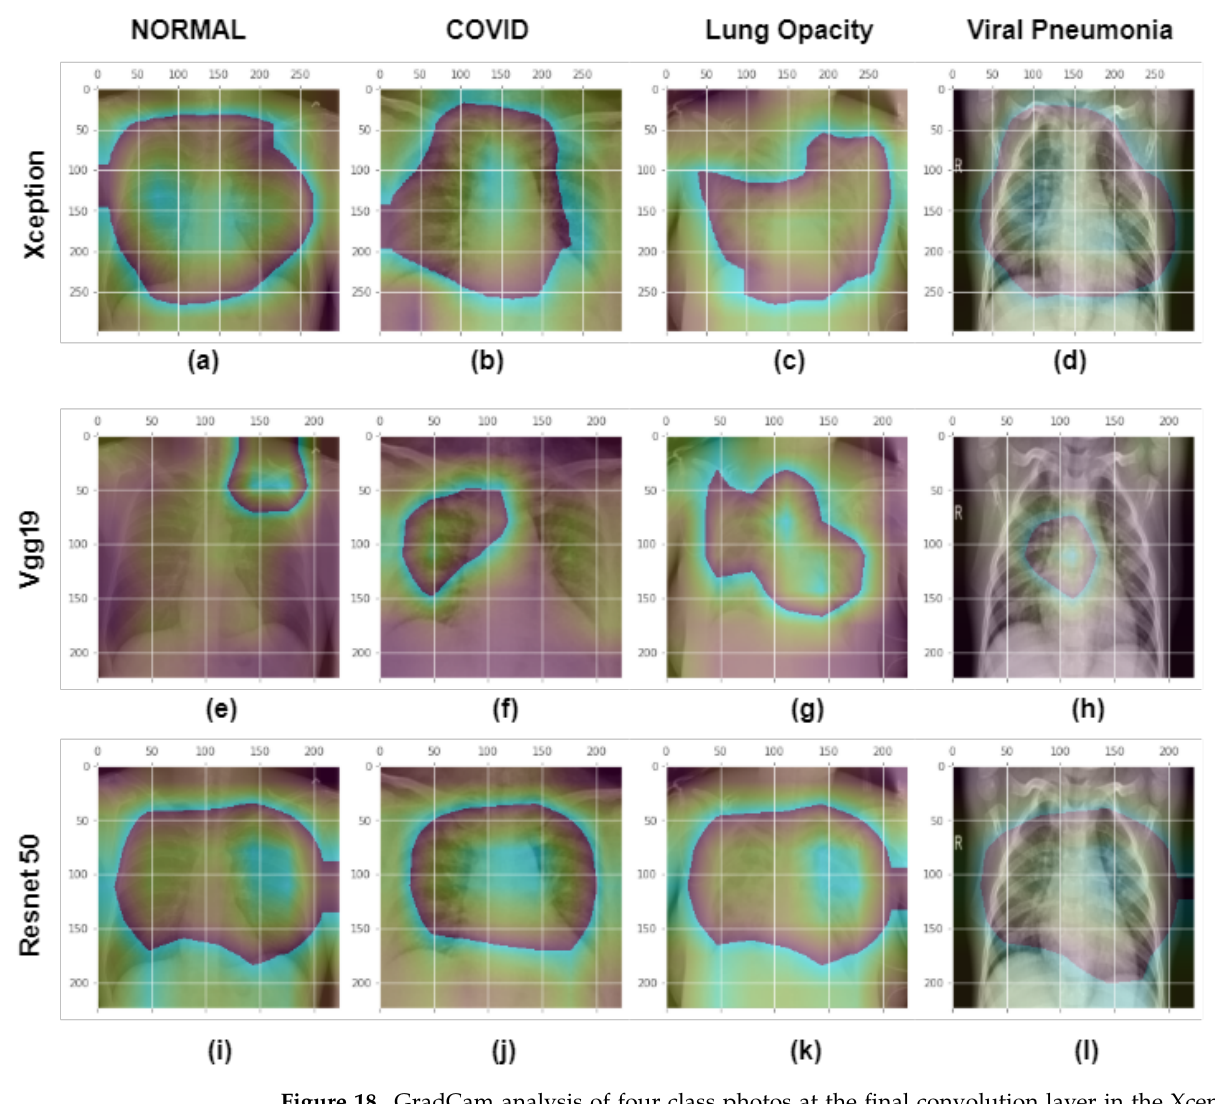
Figure 18. GradCam analysis of four class photos at the final convolution layer in the Xception, VGG19, and Resnet50 models. First row or images ( a – d ): shows superimposed images of different classes in the last layer of the Xception model. Images ( e – h ) or Second row: shows superimposed images of different classes in the last layer of the VGG19 model. Images ( i – l ) or Third row: shows superimposed images of different classes in the last layer of the Resnet model. The first, second, third, and fourth columns display superimposed images of normal. COVID, Lung opacity and non-COVID viral pneumonia classes. Xception and Resnet models classified all the images correctly, but VGG19 misclassified Normal and non-COVID viral pneumonia